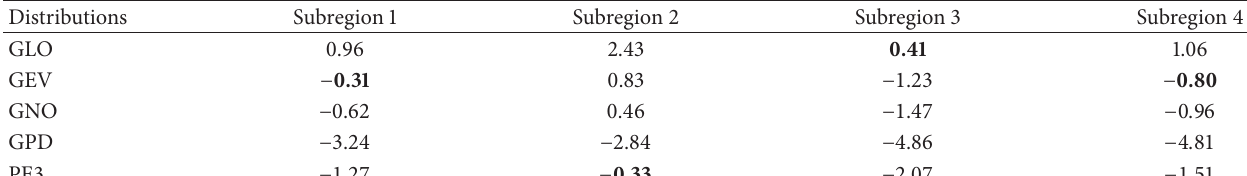
Table 5: The 𝑍 DIST of the five candidate distributions in each subregion in the WRB. The bold values mean that the distribution is the optimal model for the corresponding subregion.